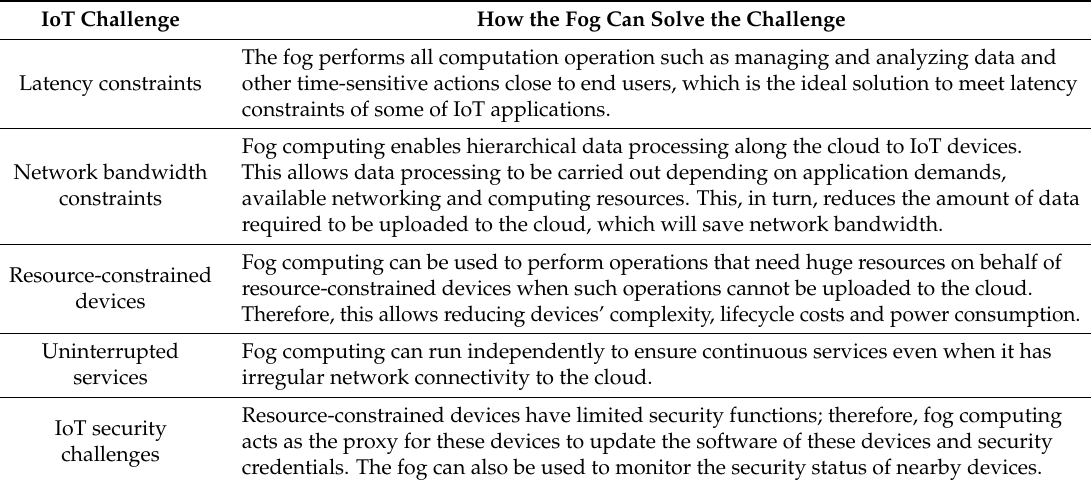
Table 2. Fog computing provides new solutions to many IoT